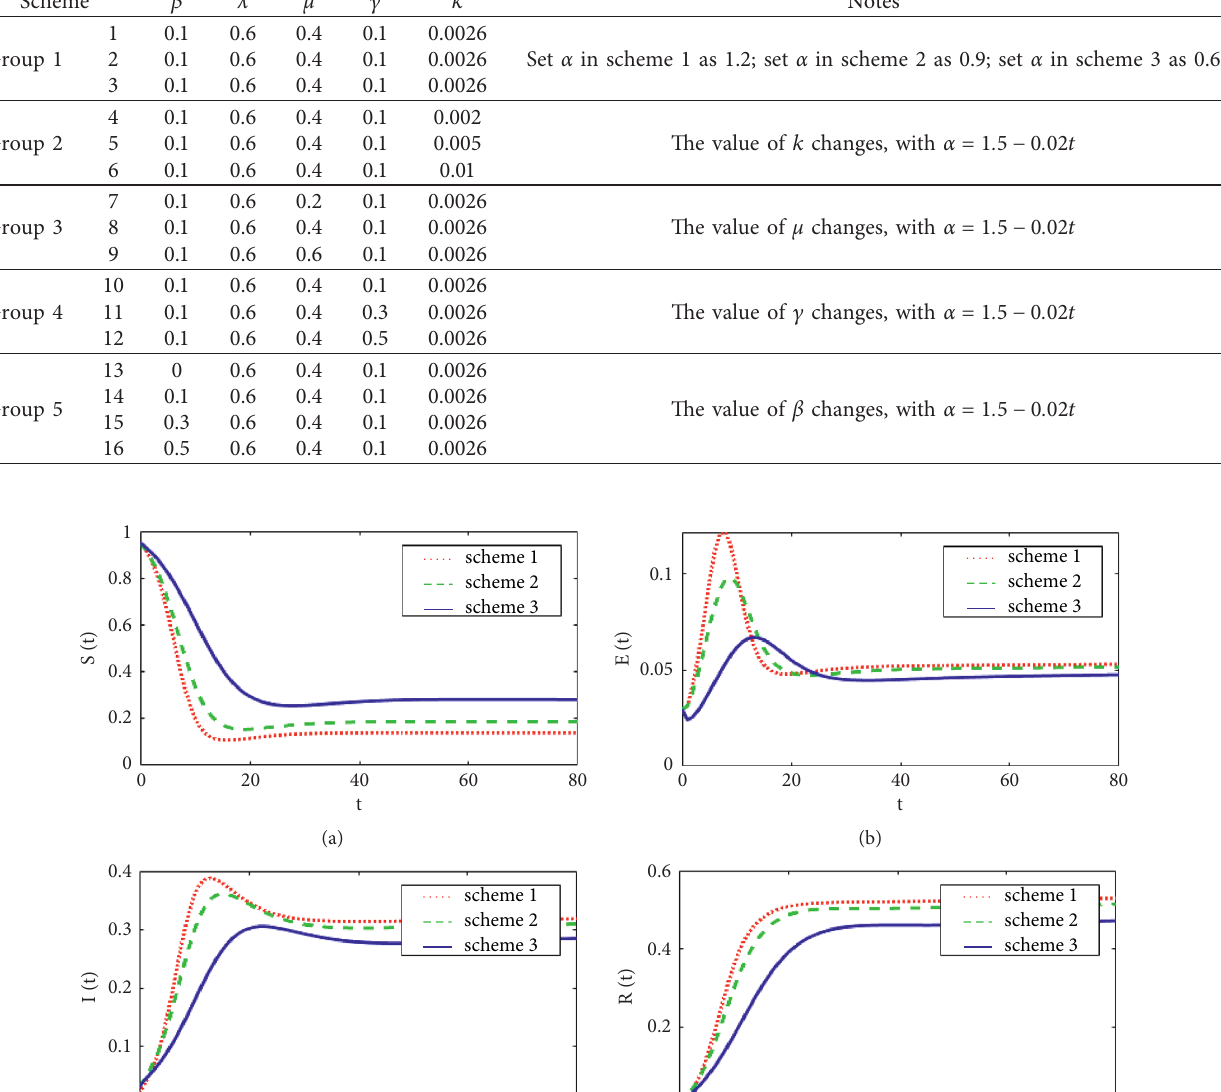
Table 2: Schemes for model parameter setting.